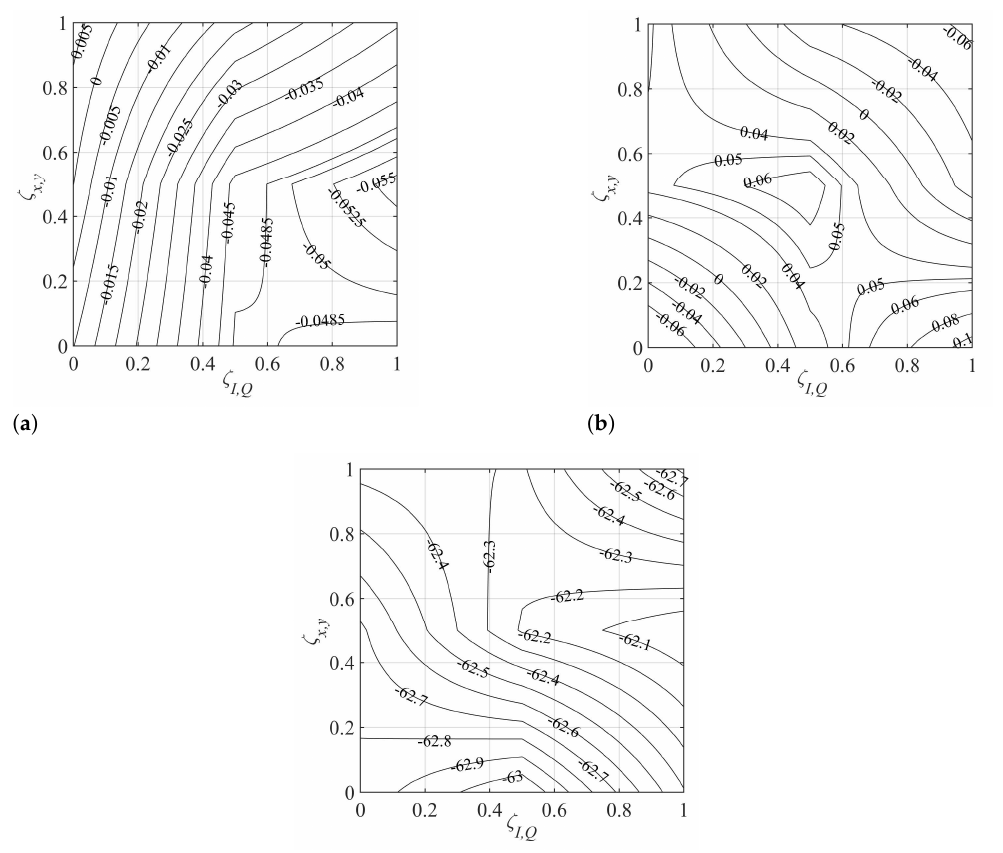
Figure 4. ( a ) Normalized mean of the I component of the ICXT field in the y direction at the interfered core output; ( b ) correlation coefficient between the I component of the ICXT field in the y direction and the Q component of the ICXT field in the y direction at the interfered core output; and ( c ) mean power of the I component of the ICXT field in the y direction at the interfered core output (in dB) for (cid:0) ∆ (cid:1) β c, mn = 0rad·m − 1 homogeneous WC-MCF with L C = 1m and L B = 10m (regime L C (cid:28) L B